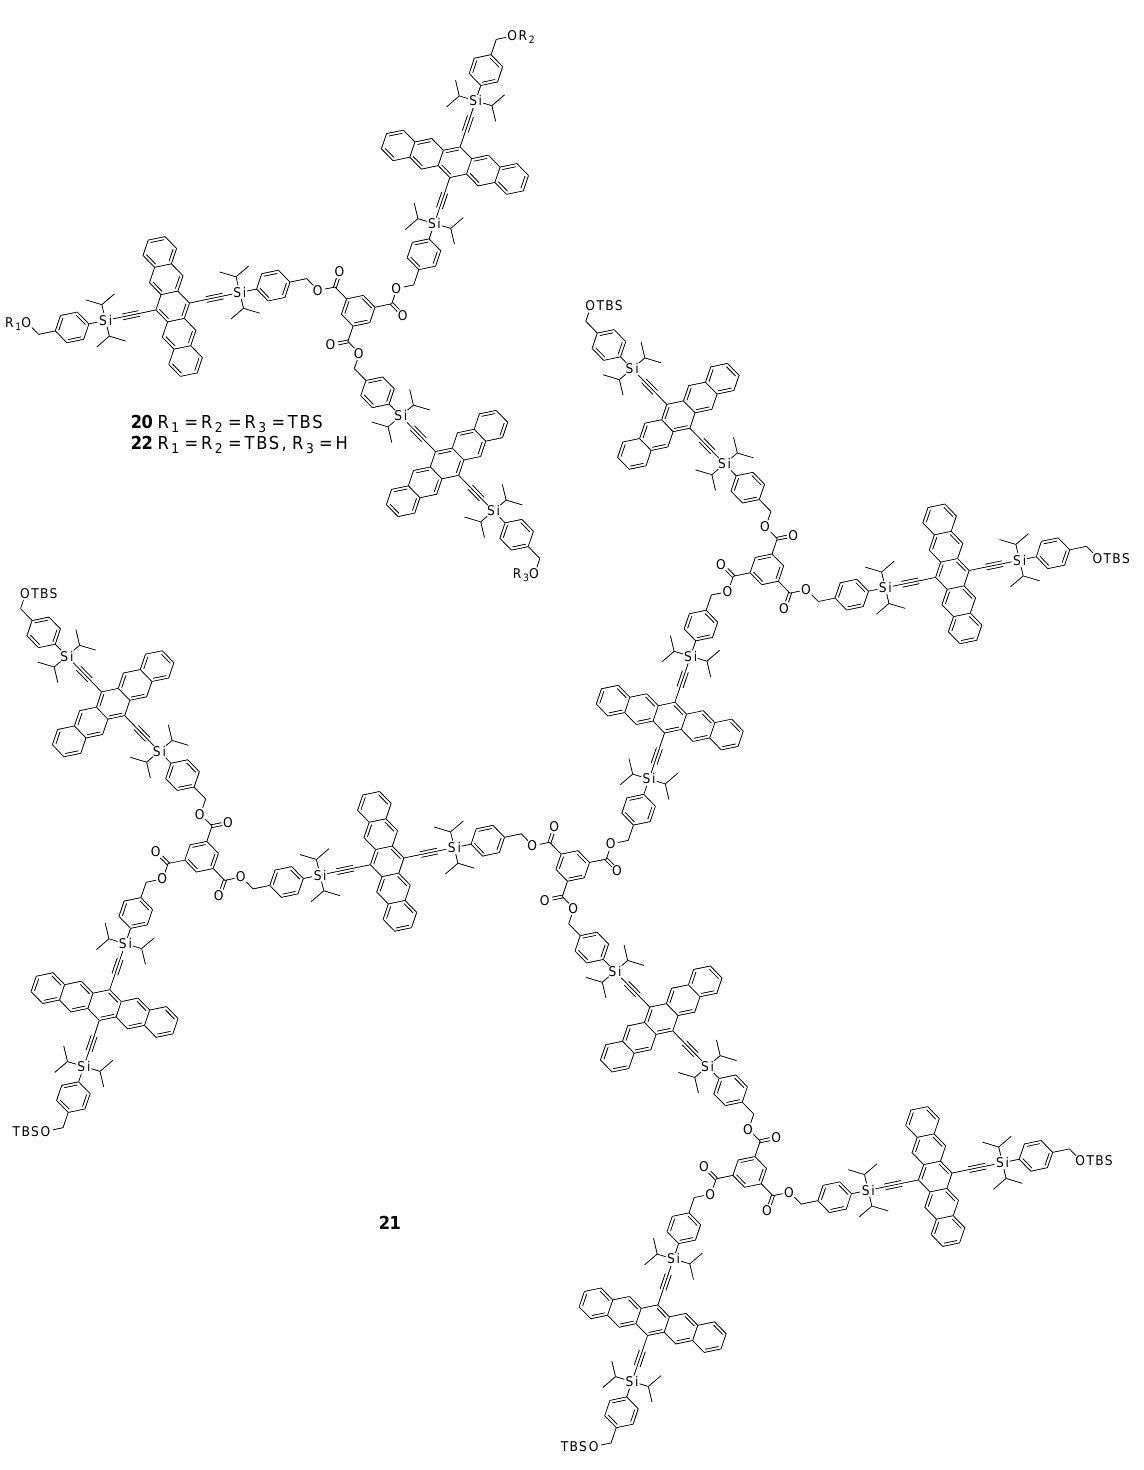
Figure 2. Structures of dendrimers 20 and 21 , and dendron 22